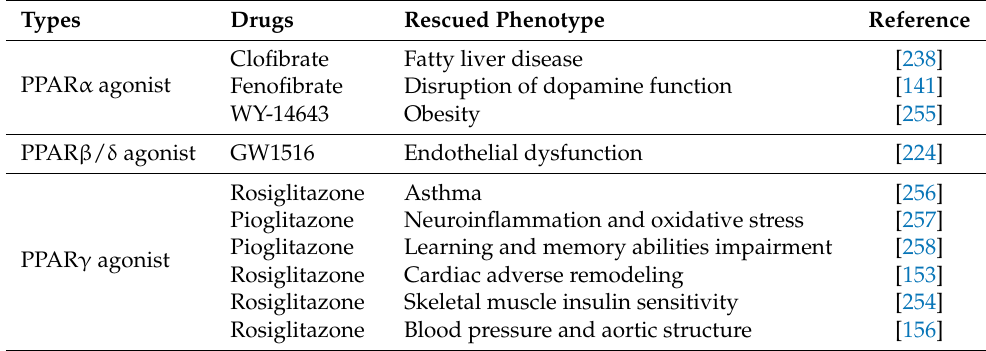
Table 2. Summary of studies on PPAR agonists in the fetal origins of adult